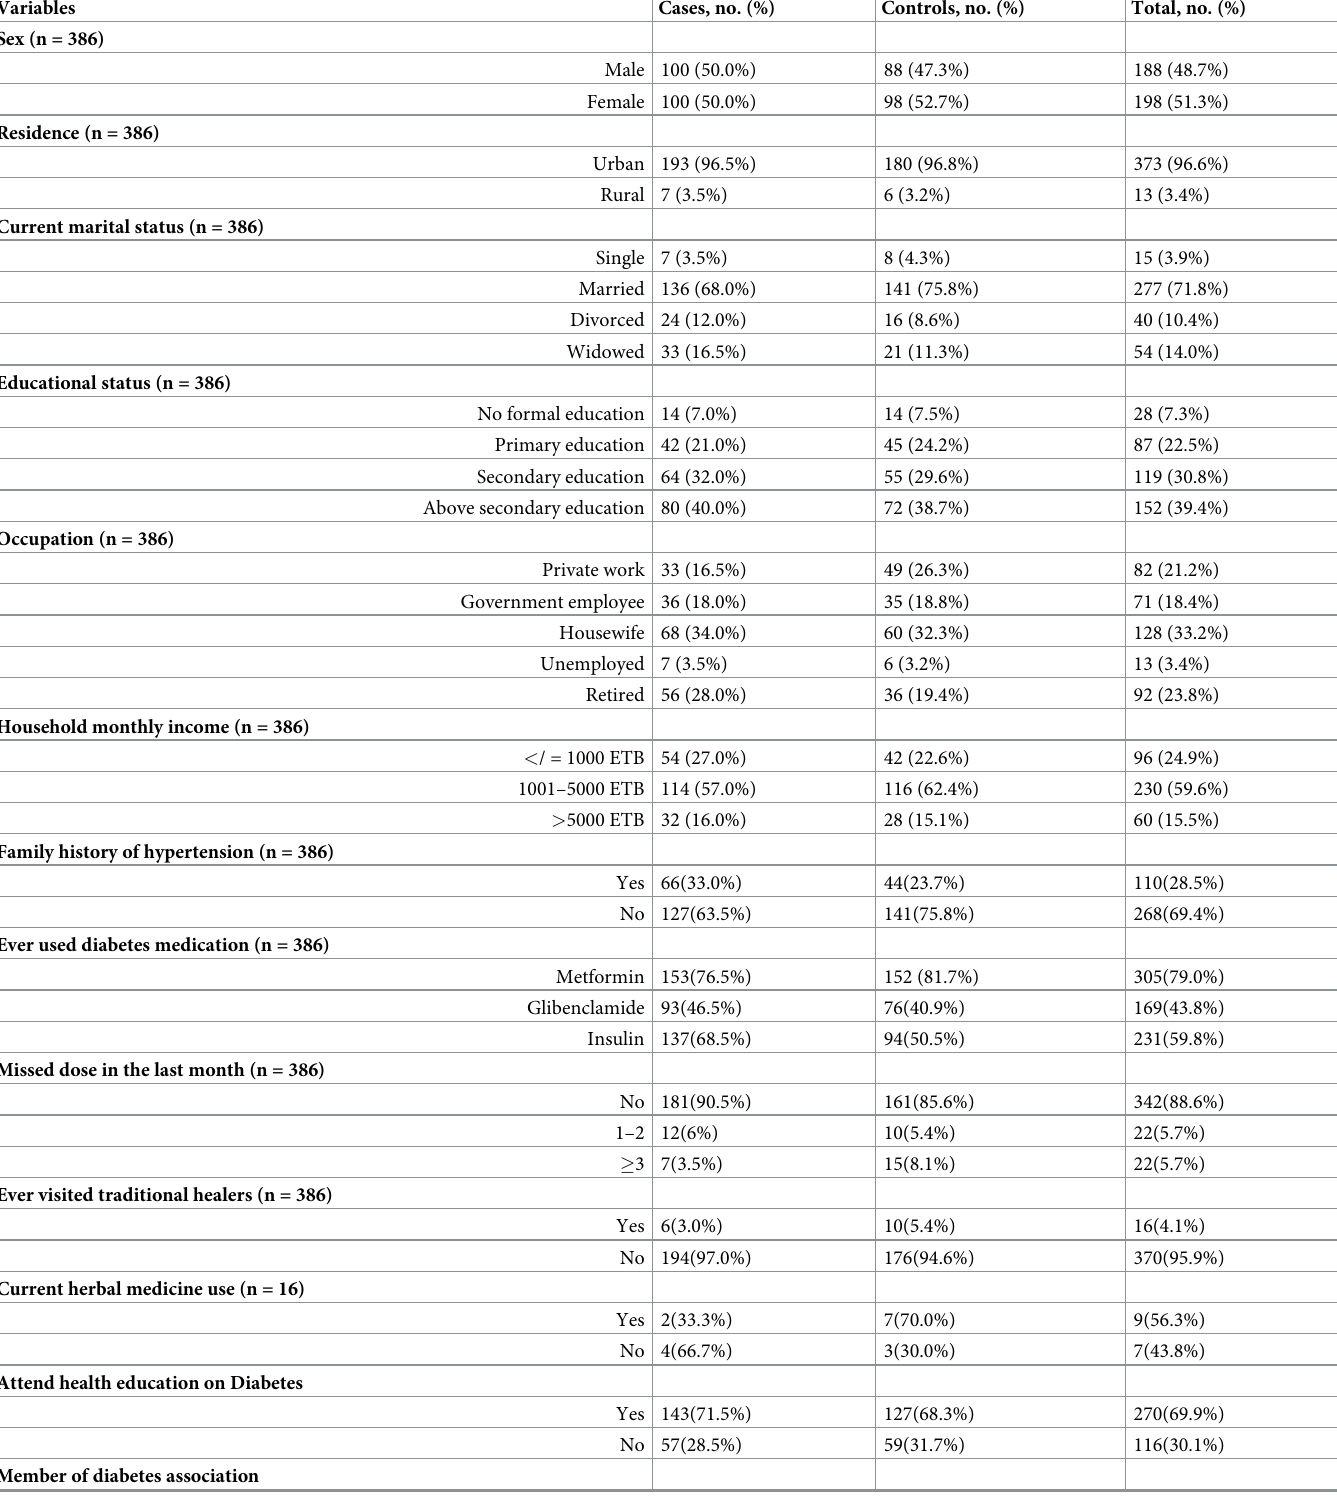
Table 1. Characteristics of people with T2DM on follow-up at TASH hospital, Addis Ababa, Ethiopia,